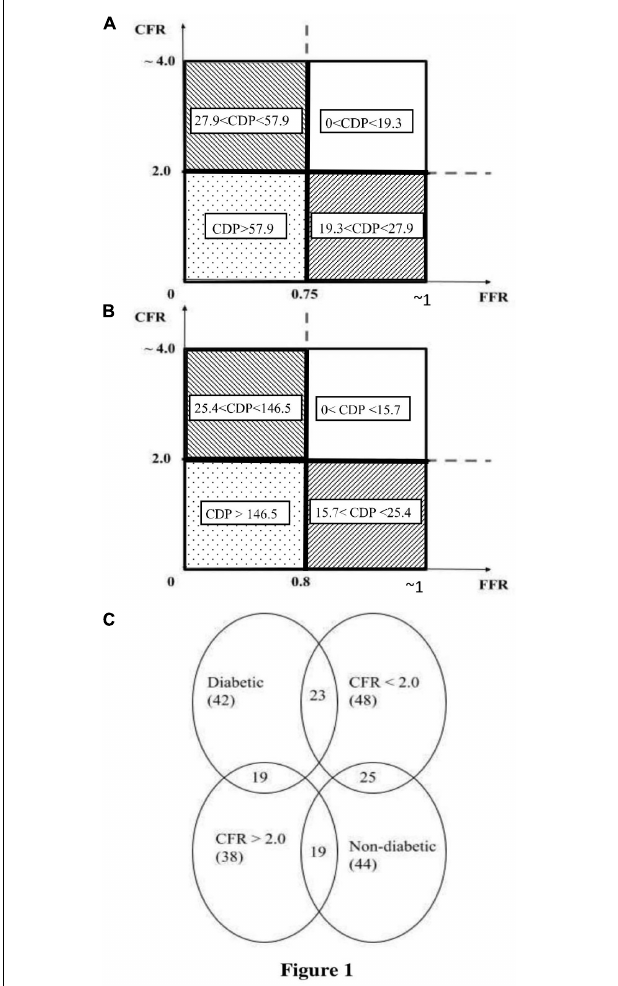
FIGURE 1 | (A) Schematic representation of the pressure drop coefficient (CDP) cutoff for FFR = 0.75 and CFR = 2.0 (Kolli et al., 2014a). (B) Schematic representation of CDP cutoff for FFR = 0.80 and CFR = 2.0 (Kolli et al., 2016). (C) Venn diagram of the MVD sub-groups extracted from the total population of 86 patients. The figure shows the number of patients in each sub-group and highlights the intersection between the diabetic and CFR < 2.0 sub-groups. MVD, microvascular disease. CFR, coronary flow reserve; FFR, fractional flow reserve.